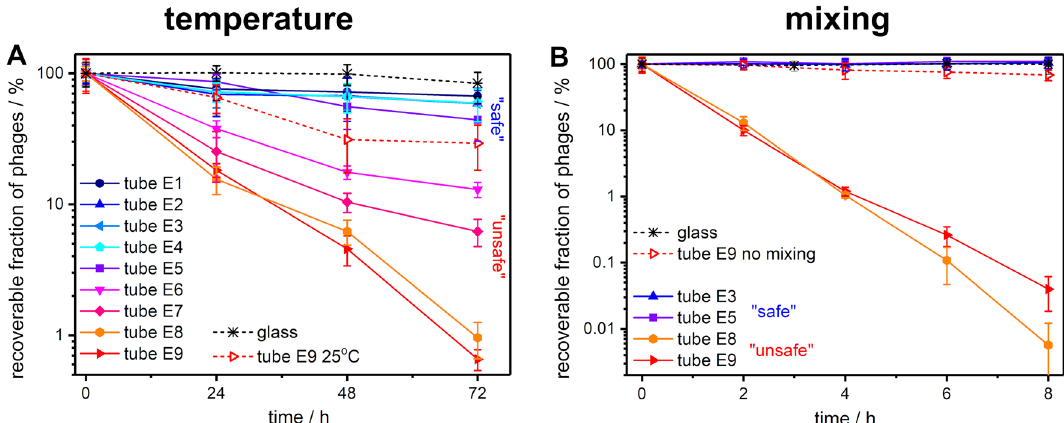
Figure 1. Effects of mixing (at 800 rpm) and elevated temperature (at 50 °C) on the number of active T4 phages in polypropylene Eppendorf-type tubes from various